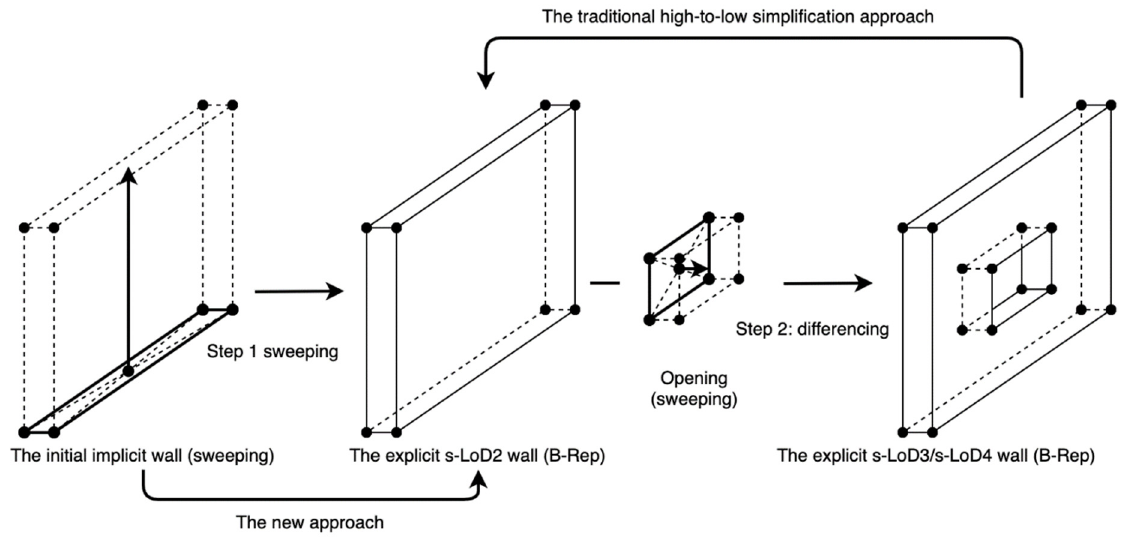
Figure 18. Wall simplification via the BIM/GIS integration approach and the traditional approach.